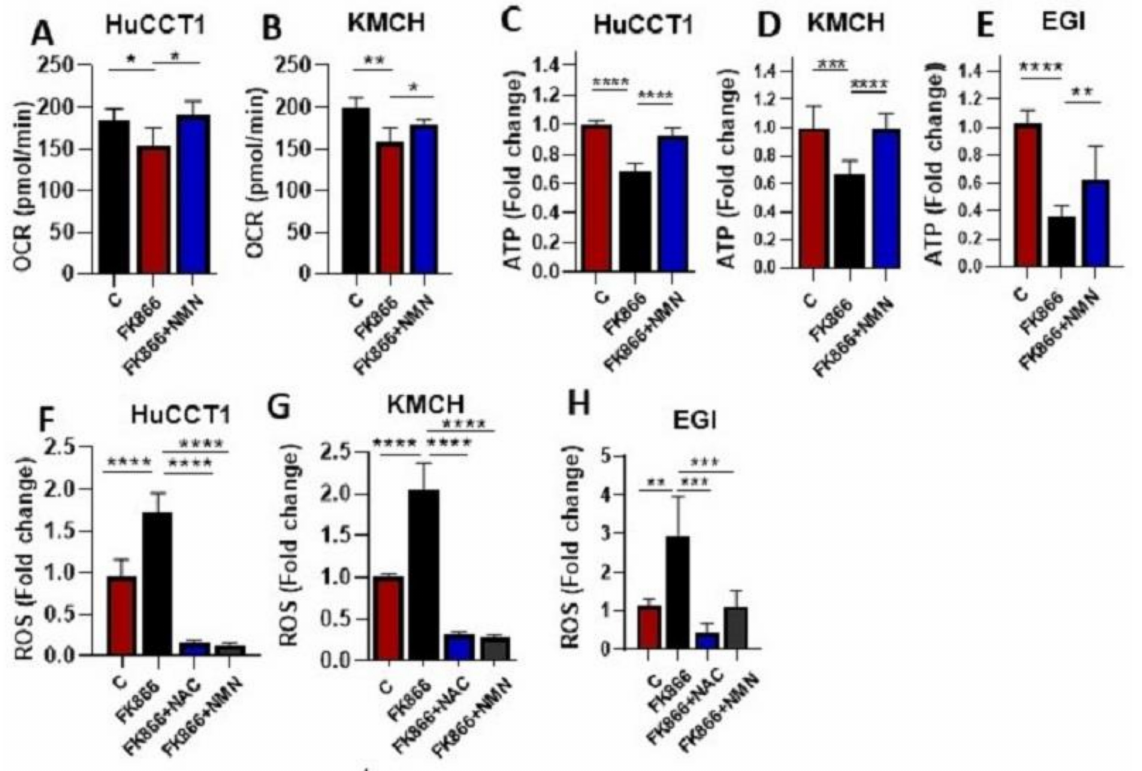
Figure 4. NAMPT inhibition disrupts mitochondrial metabolism. ( A , B ) Seahorse metabolic pheno- type assay was used to analyze the OCR values in CCA cells treated with FK866 with or without NMN for 48 h. ( C – E ) Total cellular ATP was analyzed in FK866 with or without NMN-treated CCA cells (HuCCT1, KMCH, and EGI). ( F – H ) Total cellular ROS was analyzed in FK866-treated HUCCT1, KMCH, and EGI cells with or without N-Acetyl cysteine (NAC) or NMN. ROS level is represented as relative fold change in bar graphs. (* p < 0.05, ** p < 0.01, *** p < 0.001, **** p < 0.0001).